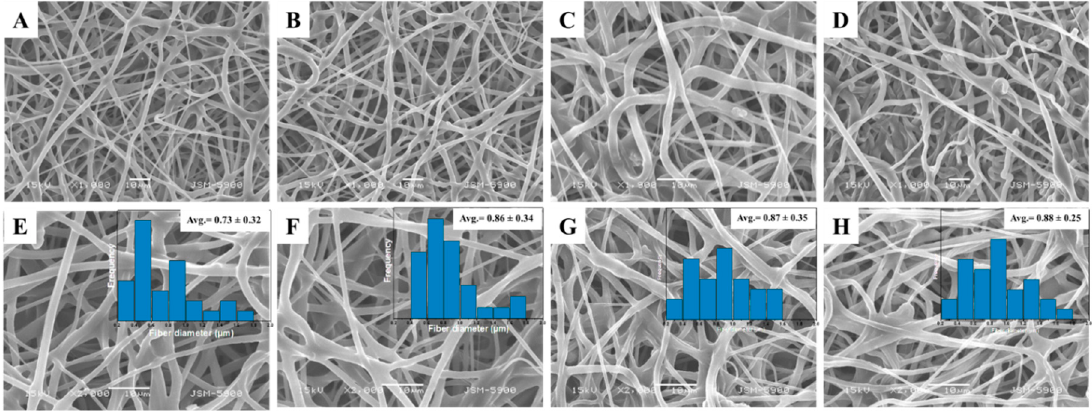
Figure 1. SEM images of ( A , E ) PCL, ( B , F ) PCL-PGS, ( C , G ) PCL-PGS-HA, ( D , H ) PCL-PGS-HA-SIM at two di ff erent magnification point. (Scale bar = 10 µ m). Inset plots represent fiber diameter distribution histograms and their average value of fiber